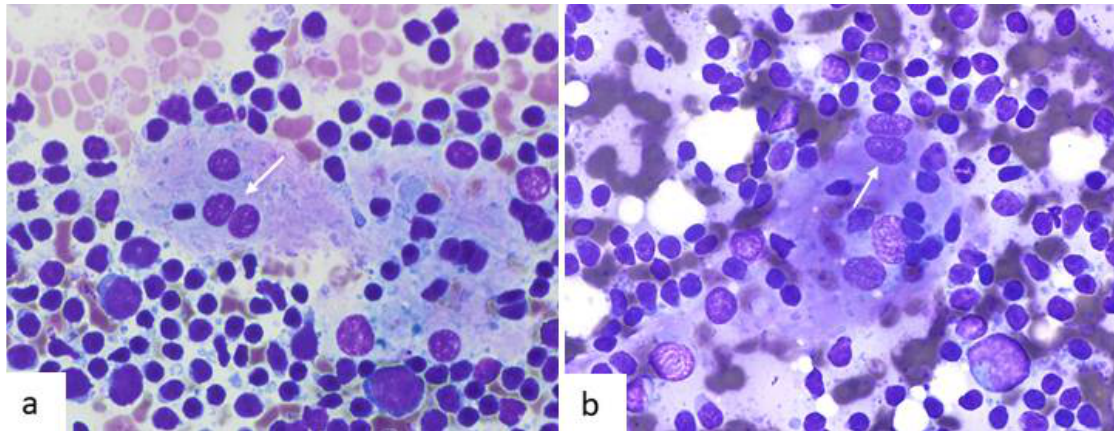
Figure 1. Cytological features of follicular dendritic cells (FDCs) in fine needle aspiration samples of reactive lymph nodes. ( a , b ) In both cases, they form a part of germinal center fragments and are mixed with numerous reactive lymphocytes. They are large cells with ill-defined cytoplasm that determines a syncytial appearance. Nuclei are round to slightly oval with occasional binucleation (white arrows) that shows molding tendency (“kissing” pattern) (Diff-Quik, ×600).